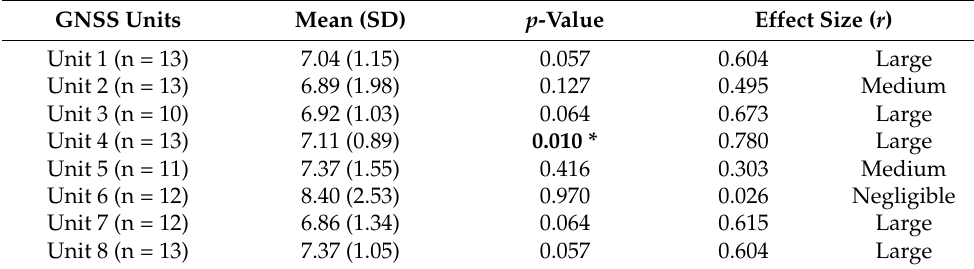
Table 3. Validity of GNSS peak speed measurements against video